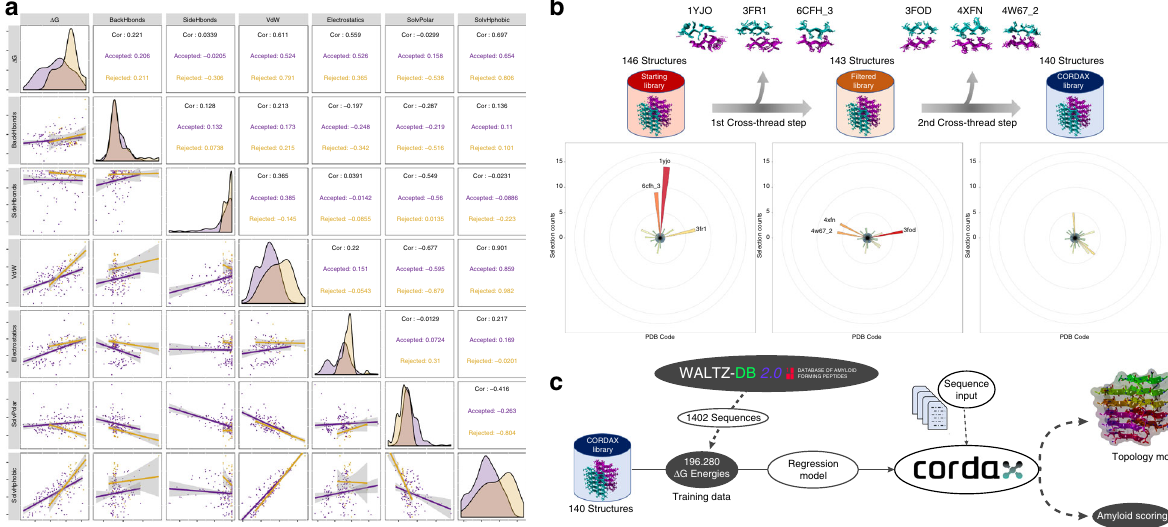
Fig. 2 Optimising the Cordax structural library. a Correlation plot of interface energies calculated using FoldX. Top half shows correlation values with scatter plots indicated at the bottom half. Rejected fragments sharing low shape complementarity (shown in yellow) have correlating weak van der Waals interfaces, as well as poor solvation energies for hydrophobic side chains compared to the remaining library (indicated in purple). Linear regression lines are shown with 95% con fi dence interval (shown in grey shaded areas). b Promiscuity sorting of the structural library performed as a two-step cross- threading process. Circular histograms highlight three major promiscuous structures ( n > 5) which were removed during the primary (PDB ID: 1YJO, 3FR1 and 6CFH_3) and secondary step (PDB ID: 3FOD, 4XFN and 4W67_2). c Schematic representation of Cordax training and the derived pipeline.